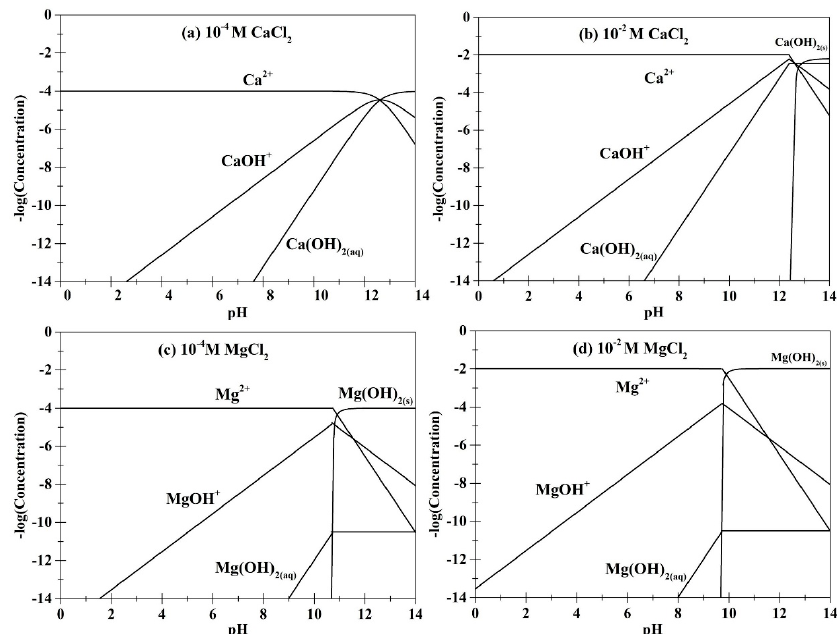
Figure 5. Ca and Mg species at 10 − 2 and 10 − 4 M.